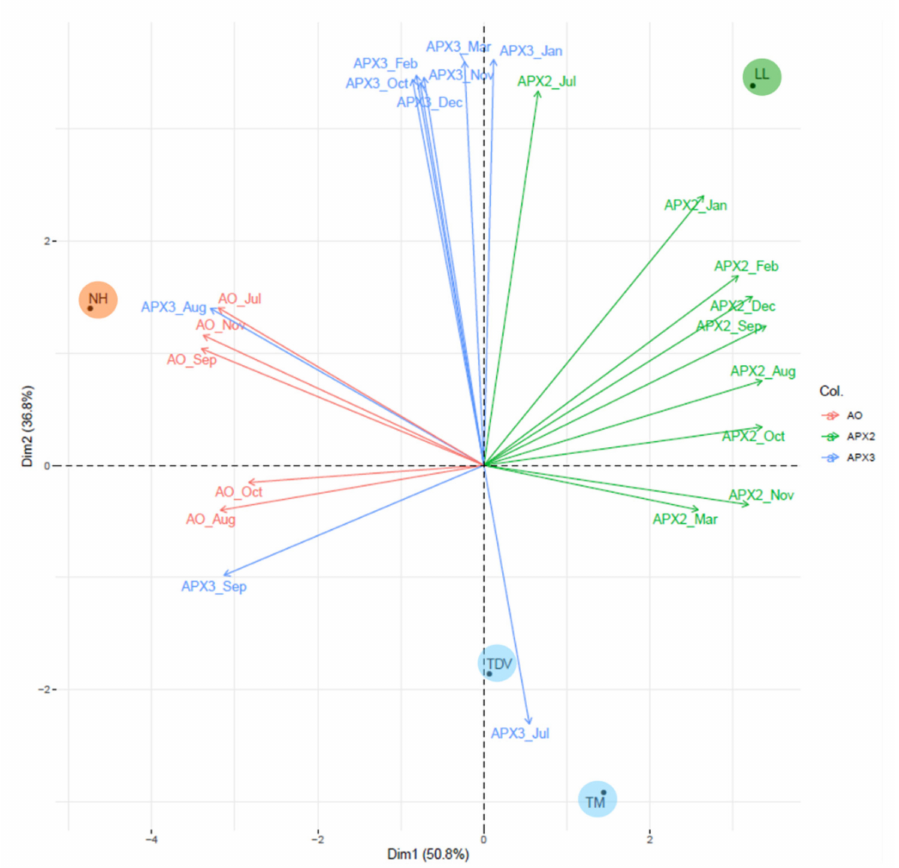
Figure 12. PCA of the expression data of APX2 and APX3 isoforms and the AO gene evaluated in the juice of Lanelate (LL), Tarocco Meli (TM), Newhall (NH), and Tarocco TDV (TDV) genotypes from July to March. Genes are indicated with different coloured lines. Varieties are indicated in coloured